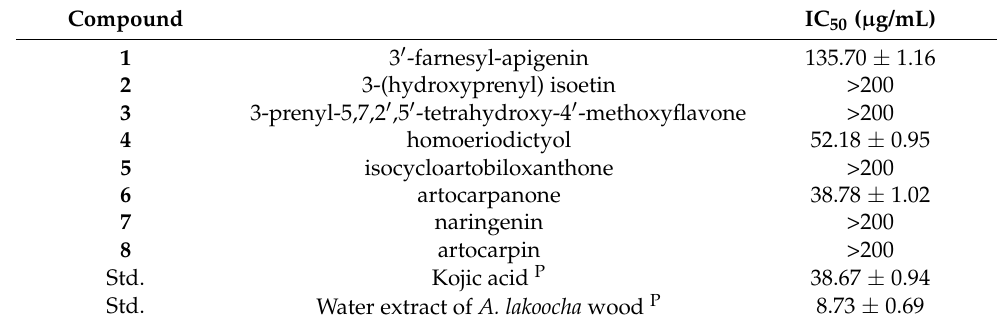
Table 1. IC 50 of isolated compounds from A. chama on tyrosinase inhibitory activity.